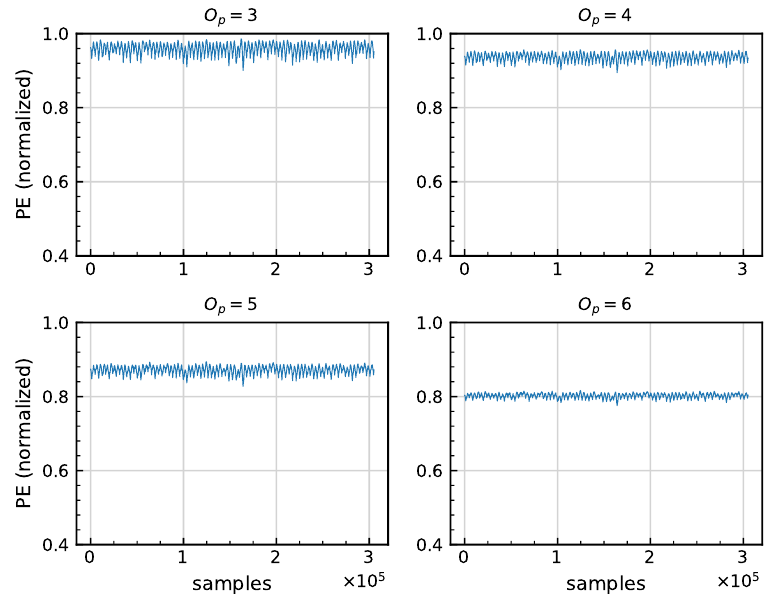
Figure 3. Several PE signals calculated from a D2 bearing at 10 rpm, with W p = 2048 and varying O p